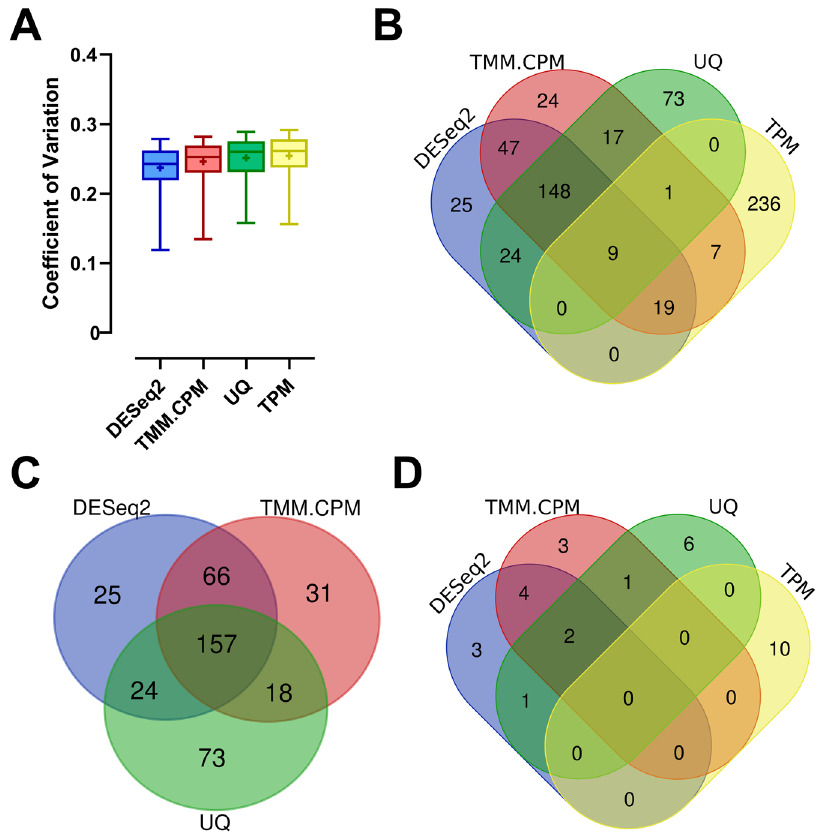
Figure 1. Transcriptome-wide analysis of the stability of candidate reference genes for quantitative RT-PCR assays across six life-cycle stages of S. mansoni . Twenty-four RNA-Seq libraries comprising six S. mansoni life- cycle stages were analyzed using four different normalization methods, namely DESeq2, TMM.CPM, UQ, and TPM. ( A ) Box plots of the coefficients of variation (CV), which were calculated based on the expression levels of the 272 genes with the lowest coefficients of variation, representing 2% of all genes detected in the RNA-Seq libraries, and analyzed with each of the four normalization methods indicated in the x-axis. The horizontal line represents the CVs’ median for each normalization method, while the + signal represents the mean. The boxes and whiskers represent the inter-quantile and min to max ranges, respectively. ( B ) Venn Diagram shows the number of genes and the overlap among the 272 most stable genes found in each of the four RNA-Seq normalization methods. ( C ) Venn Diagram showing the number of genes and the overlap among the 272 most stable genes in the DESeq2, TMM.CPM and UQ normalization methods. ( D ) Venn Diagram showing the number of genes and overlap among the ten most stable genes according to their CVs in each